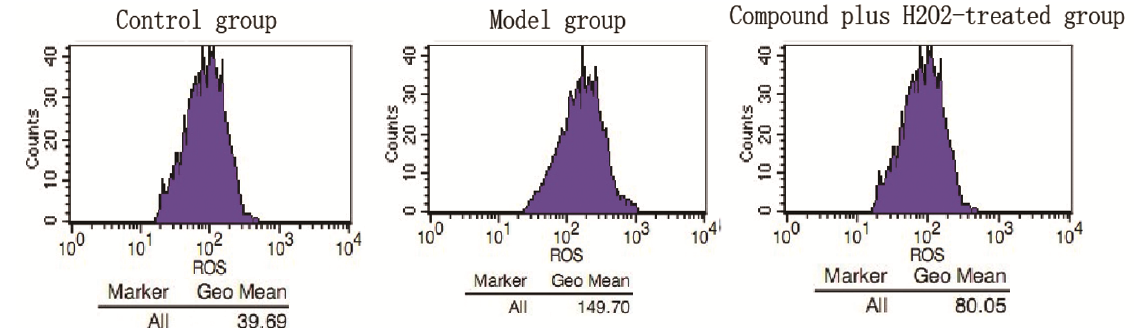
Figure 5. Effects of compound 1 on the ROS contents in HUVECs injured by H were treated with compounds 1 (50 µM) for 24 h then measured using an DCFH-DA probe according to the manufacturer’s instructions. The level of ROS was increased in the model group (H O -treated group), while treatment with compound 1 , the content of ROS was 2 2 decreased